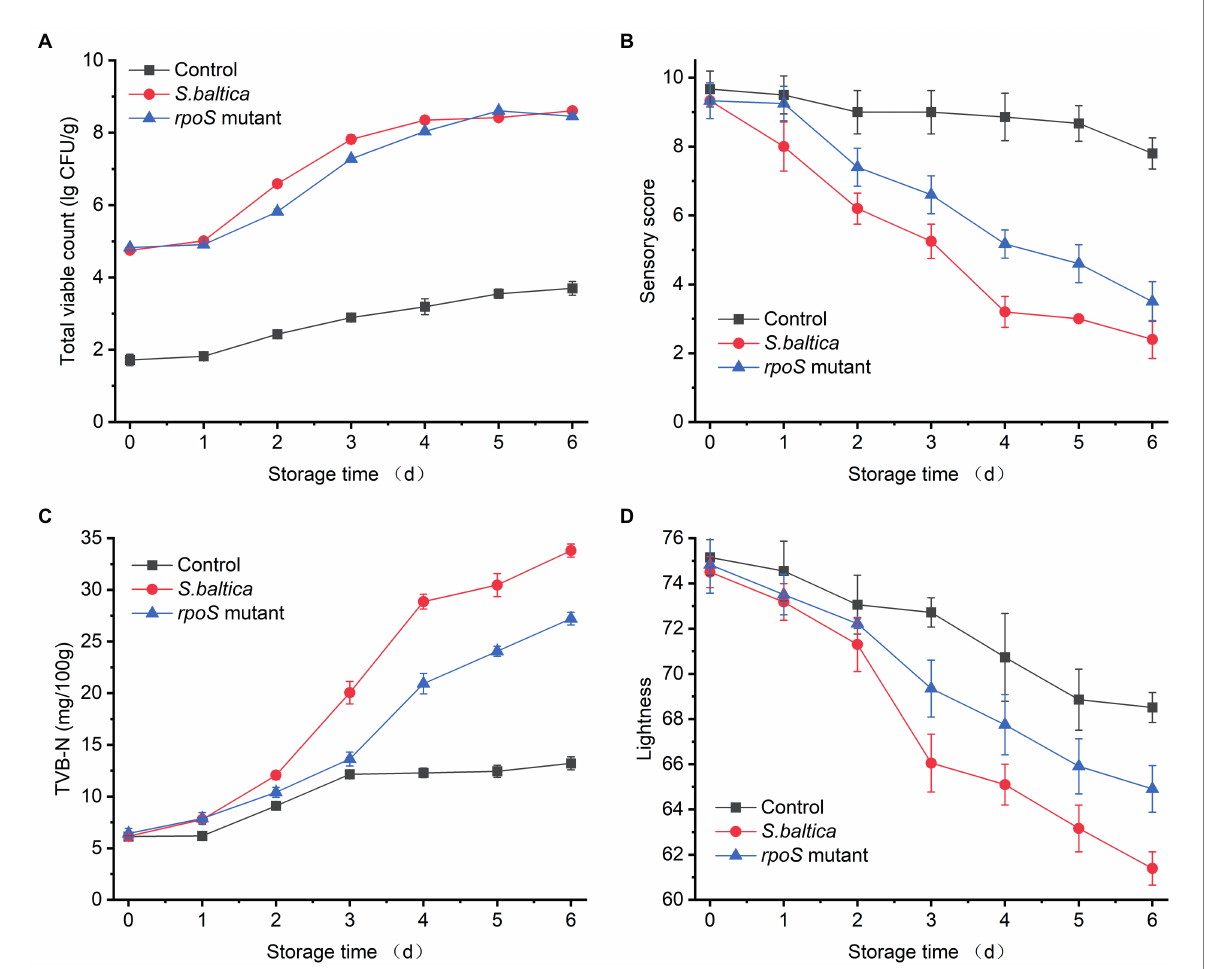
FIGURE 1 Changes in total viable counts (A) , sensory score (B) , TVB-N (C) , and lightness (D) of yellow croaker fillets inoculated with Shewanella baltica and rpoS mutant during storage at 4 °